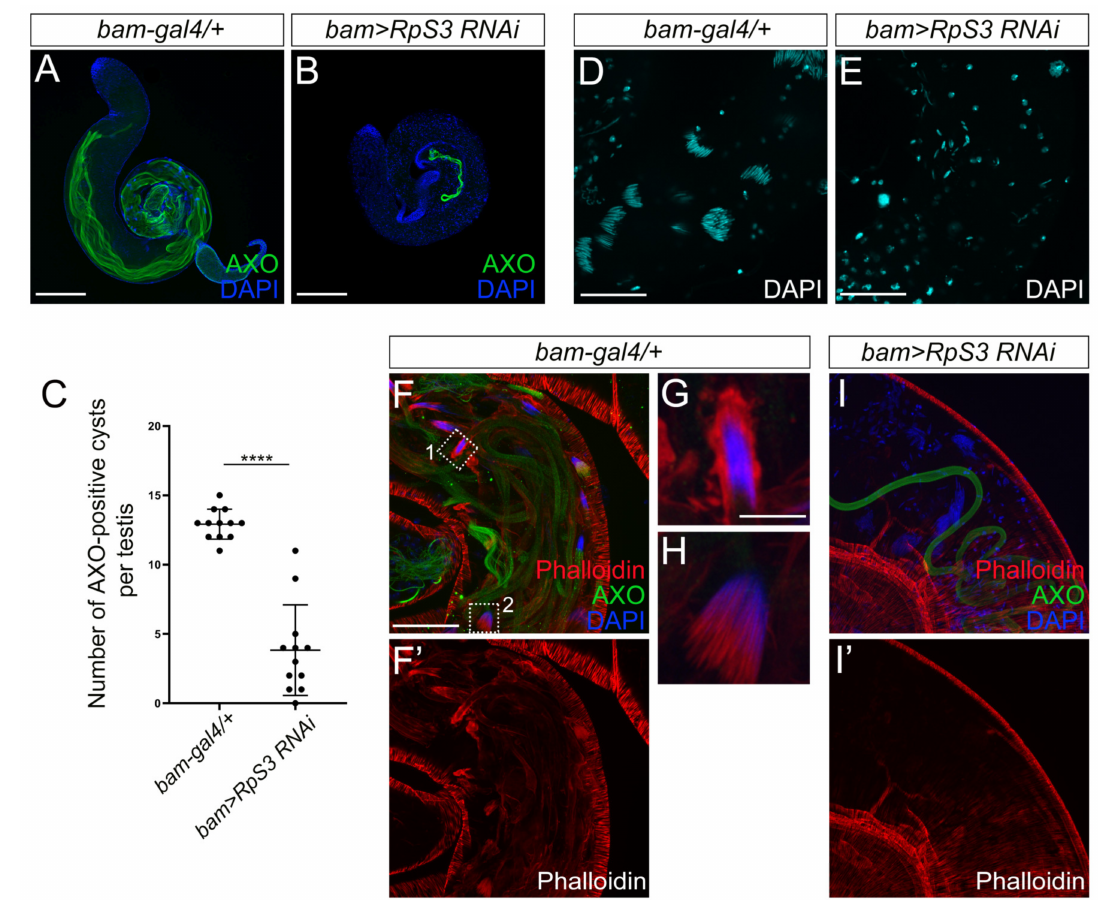
Figure 4. Elongation and individualization of spermatids were disrupted in the RpS3 -knockdown testis. ( A , B ) The elongated cysts were labeled by AXO-49 staining (green) that recognizes the poly- glycylated axonemal tubulin marker. Compared with the control testis, the number of elongated cysts was dramatically reduced in bam>RpS3 RNAi testis. ( C ) The average area of AXO-49 positive cysts was quantified in control testes ( n = 13) and in bam>RpS3 RNAi testes ( n = 19). Each dot indicates one sample measured. **** p < 0.0001. ( D , E ) DAPI staining indicated the spermatid nuclei bundles at the tail part of the control testis ( D ), whereas the spermatid nuclei were separated in bam>RpS3 RNAi testis ( E ). ( F , F’ , G – I , I’ ) The individualization complexes (ICs) were visualized by phalloidin staining (red) in the tail part of the testes. The actin cap (indicated by dashed box 1 in F ) and actin cones (the dashed box 2 in F ) were shown in an enlarged view ( G , H , respectively). IC formation